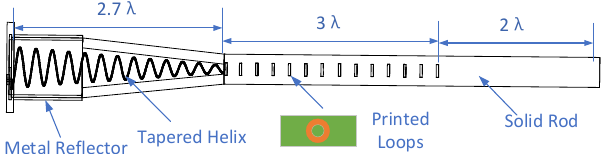
Figure 1. ( a ) Application areas of proposed antenna ( b ) Fabricated prototype of Embedded Helix and dielectric rod antenna.